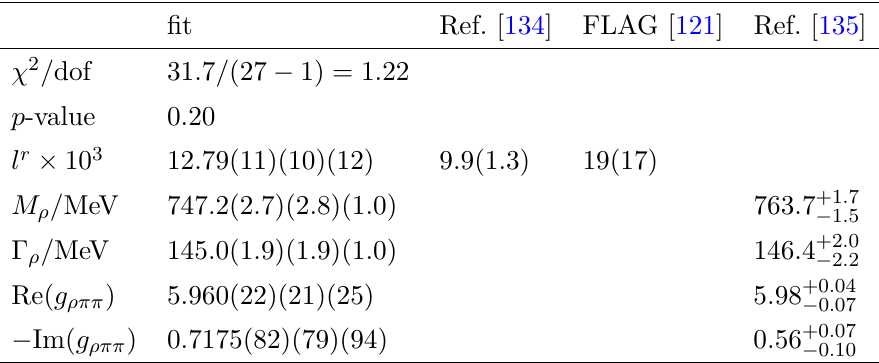
Table 2. The outcomes of the IAM fit to the ππ data. The first error arises due to the statistical error of the ππ data, the second due to the error of the lattice spacings, and the third due to the error of the literature value of F . The third and fourth column contain reference values for the LEC from ChPT and lattice QCD [121–126], respectively, while the fifth column lists the ρ properties as determined via Roy-like